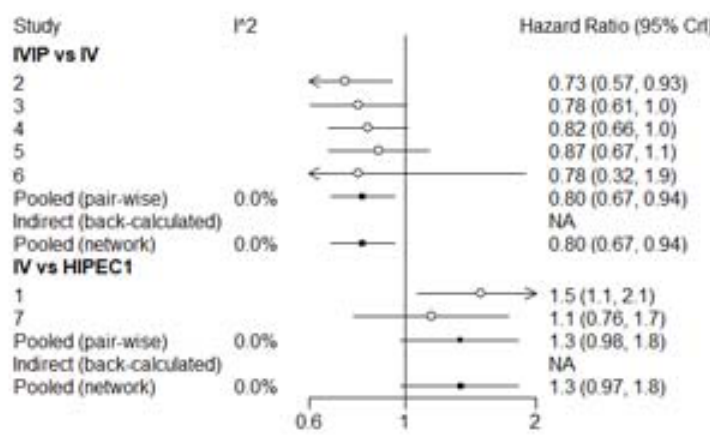
Figure A1. Forest plot of OS